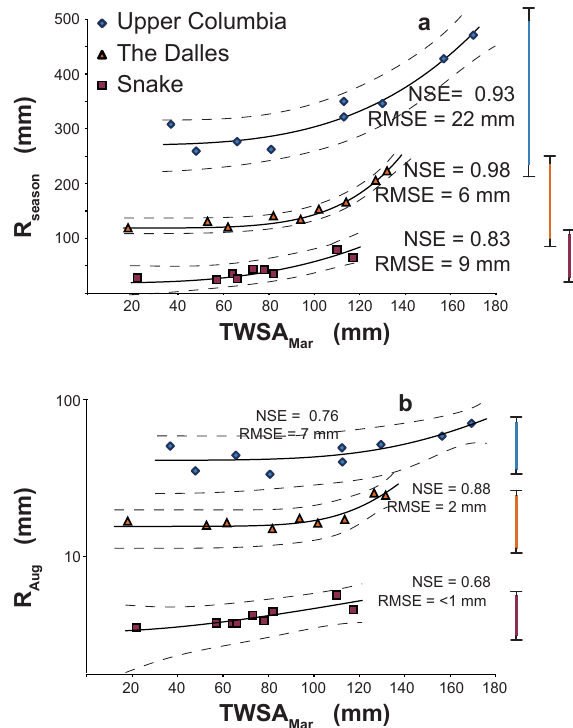
Figure 7. (a–b) Measurements of terrestrial water storage anoma- lies in March (TWSA Mar ) effectively predict the cumulative runoff for April–September ( R season ; (a) and help describe how these three regional watersheds function as simple non-linear systems. TWSA Mar also predicts mean runoff for August ( R Aug ; (b) one of the driest months of the year when demand for water is at its peak. The hashed lines represent the 95% confidence intervals. The box plots to the right of each plot represent the range of R for the respective watershed from WY’s 1969–2012. Note the semi-log y axis on (b) . For complete results and parameters from the empiri- cal model please refer to Tables 1, 2, 3, A3, and